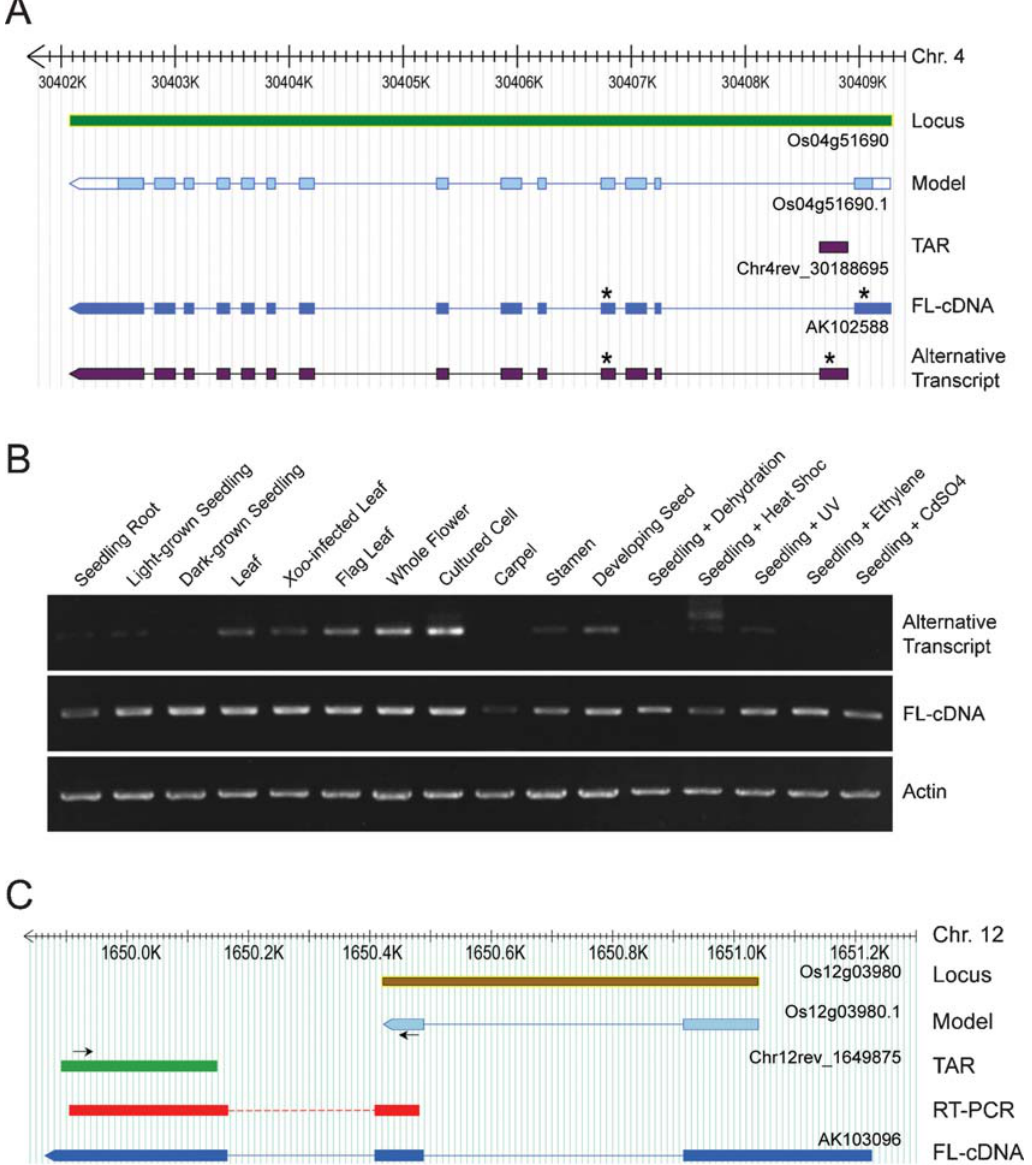
Figure 4. Experimental verification of selected non-exonic TARs representing uncharacterized portions of gene models. (A) Annotation of an intronic TAR. The TAR Chr4rev_30188695 is in the first intron of the gene model Os04g51690. A TAR-containing transcript was proposed in which the TAR serves as the alternative first exon. (B) RT-PCR analysis of the transcript abundance in diverse conditions for the FL-cDNA AK102588 and the TAR- initiated alternative transcript. Positions of the primers are indicated by the asterisks shown in (A). (C) Annotation of a proximal intergenic TAR 3 9 to a gene model. Arrows indicate the primer positions.